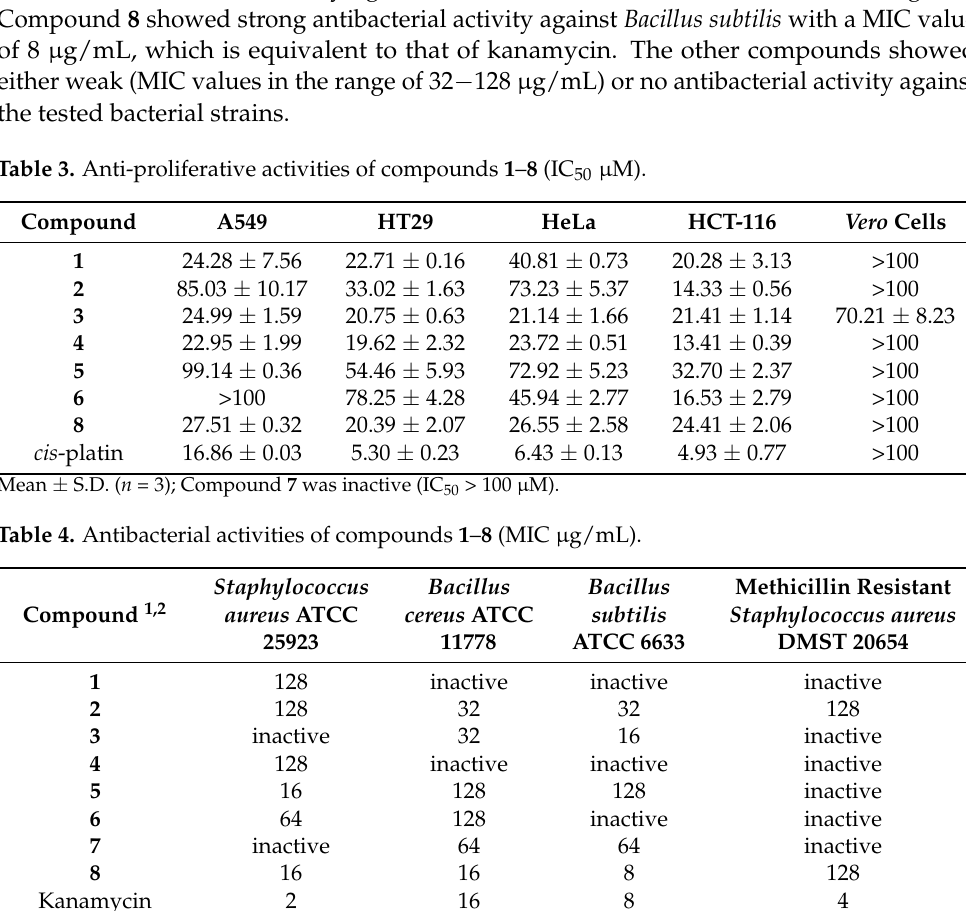
Supplementary Materials: The following are available online. Table S1: Secondary metabolites from Neonothopanus nambi , Figure S1: Chemical constituents from Neonothopanus nambi , Figure S2: Experi- mental and calculated ECD spectra of 2 (black line, experimental ECD of 2 ; red dashed line, calculated for 5 S , 6 S , 8 S , 9 S , 10 S , 11 R , 13 S , 14 S configurations; black dashed line, calculated for its enantiomer). Figure S3: Structures of conformers of 2 computed by HyperChem, Table S2: Conformer Boltzmann distribution of 2 computed by HyperChem, Figure S4: IR spectrum of compound 1 , Figure S5: UV spectrum of 1 in methanol, Figure S6: HRESIMS spectrogram of compound 1 , Figure S7: 1 H NMR spectrum of compound 1 in CDCl 3 , Figure S8: 13 C NMR spectrum of compound 1 in CDCl 3 , Figure S9: DEPTQ spectrum of compound 1 in CDCl 3 , Figure S10: 1 H- 1 H COSY NMR